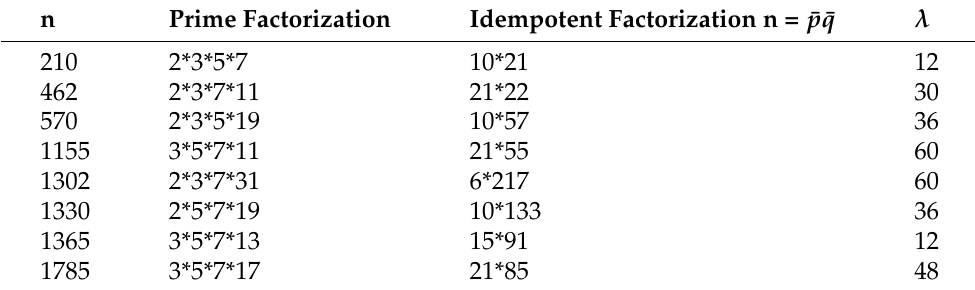
Table 1. The first 8 integers with fully composite idempotent